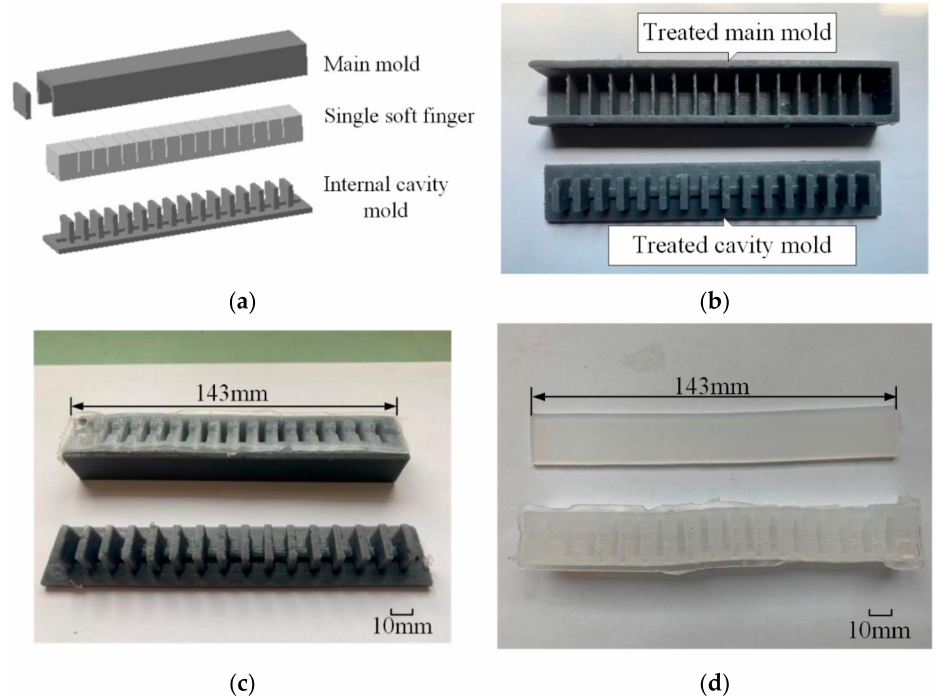
Figure 8. ( a ) The forming principle of fabricating a single soft finger; ( b ) the treated mold; ( c ) single soft finger in the mold; ( d ) the single soft finger.